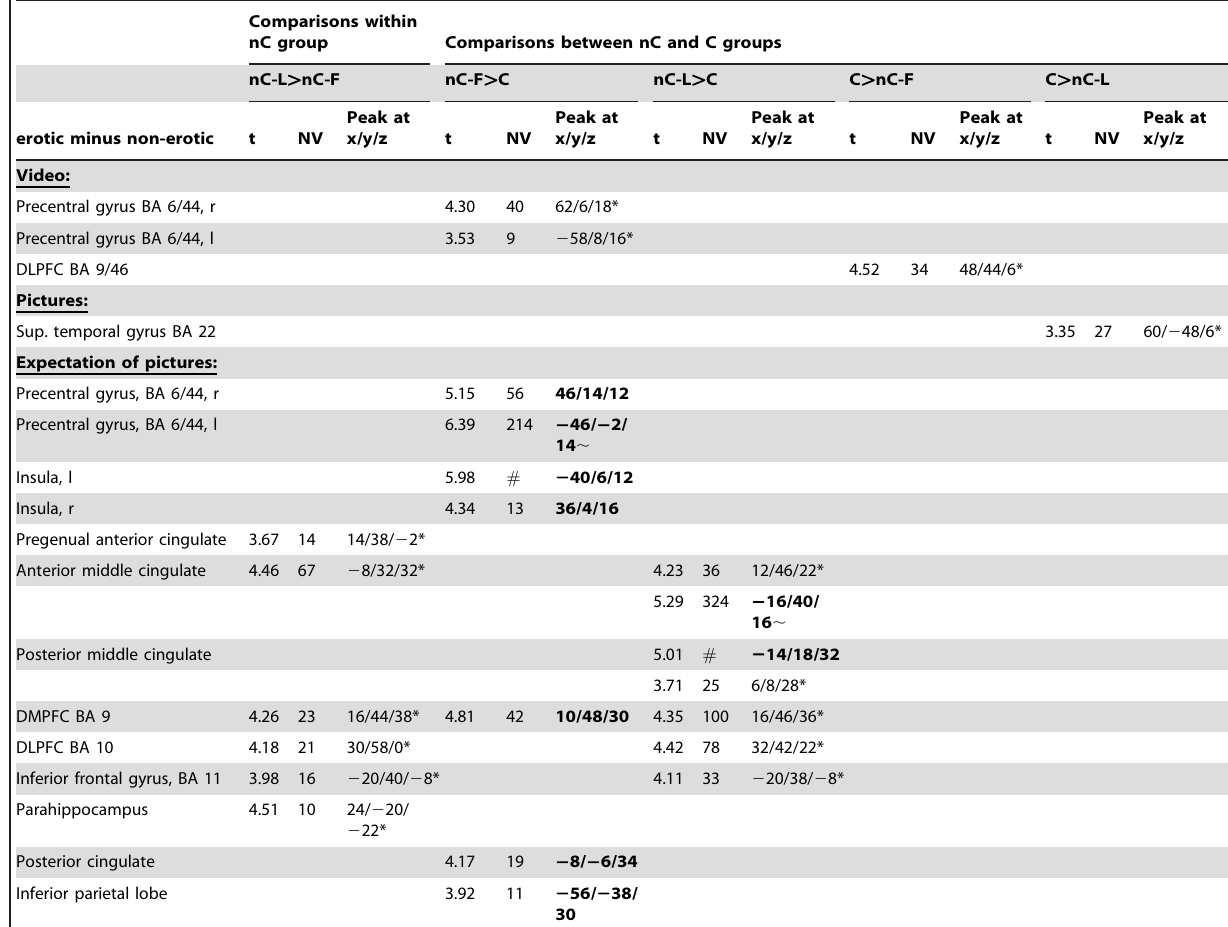
Table 2. Significant condition-by-hormonal levels interaction effects (whole brain